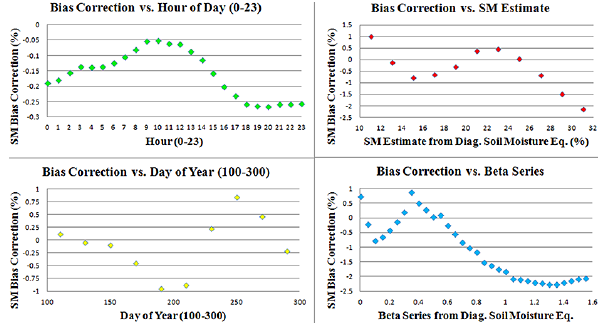
Figure 9. Bias correction analysis, SCAN site 2013 (LWC, woods, sandy